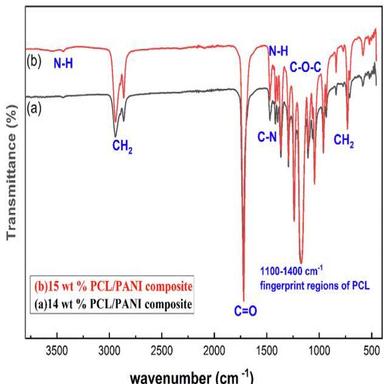
FTIR spectra of (a) 14 wt% and (b) 15 wt% PCL and PANI composite.